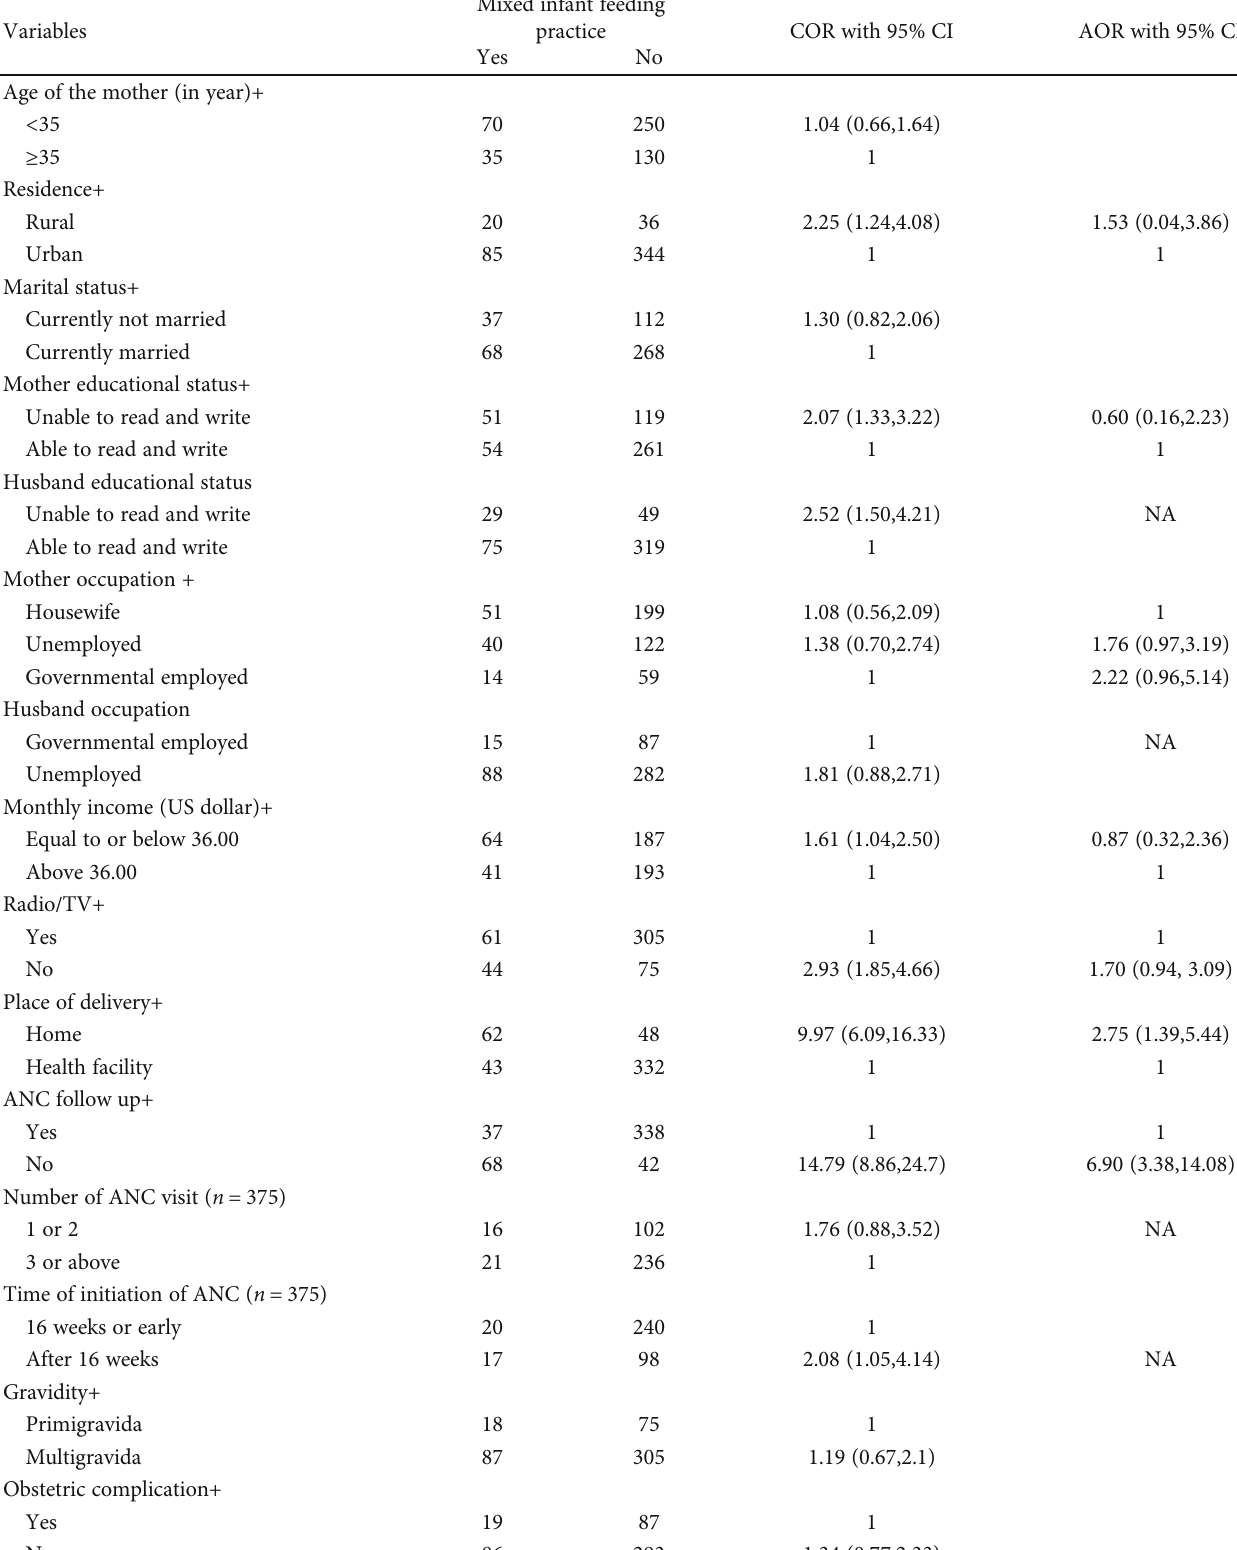
Table 3: Determinants of mixed infant feeding practice among HIV-positive women in care in public health institutions in Gondar city, Northwest Ethiopia, 2017 ( n = 485